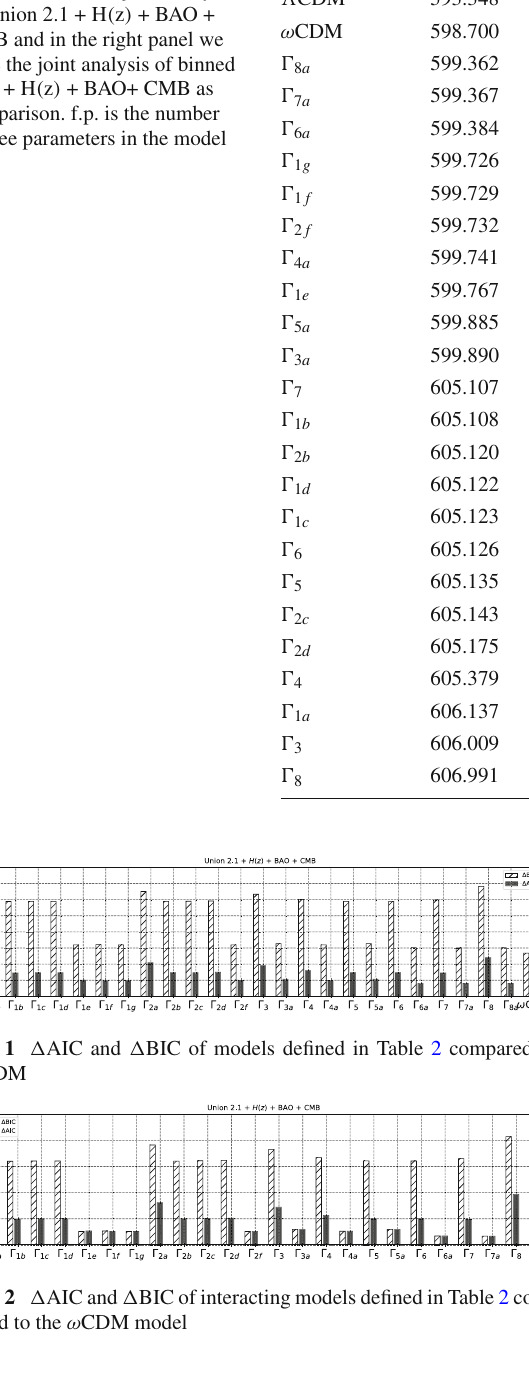
It is noteworthy to mention that interaction (cid:8) 8 a is marginally better than other interacting models according to AIC and BIC and this interaction alleviates the